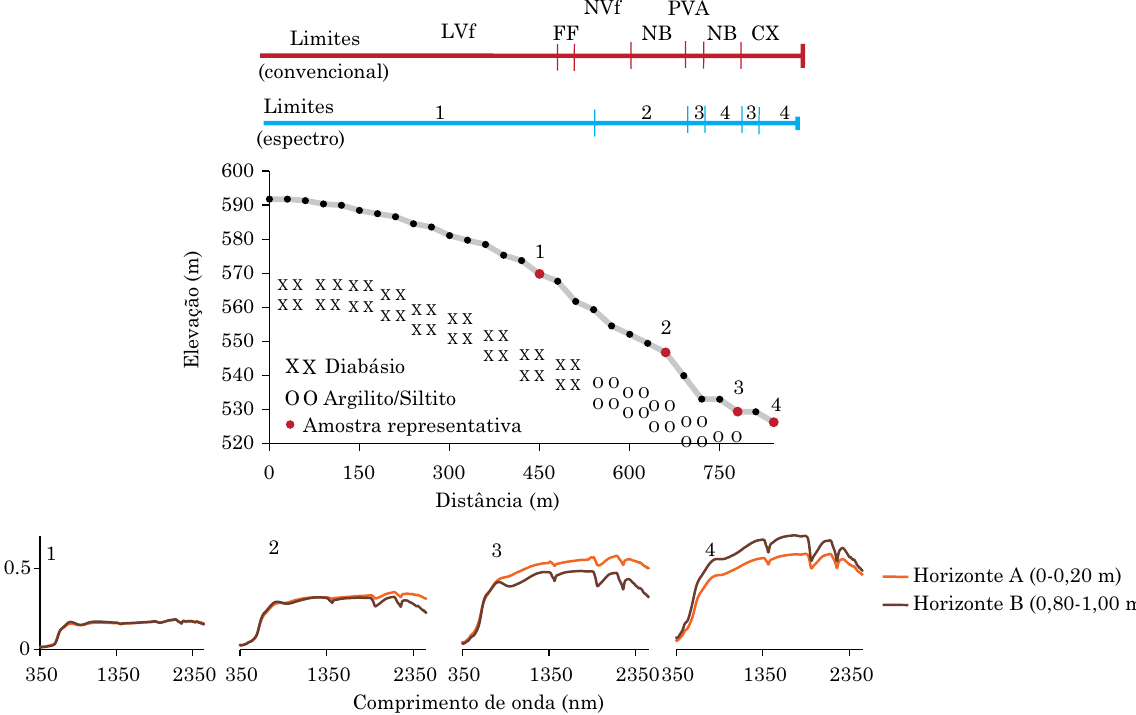
Figura 2. topossequência a e limites de classes de solos determinados por métodos convencional e espectral. os pontos 1, 2, 3 e 4 correspondem às amostras representativas às suas unidades espectrais (pontos em vermelho), evidenciando as curvas espectrais dos horizontes a e